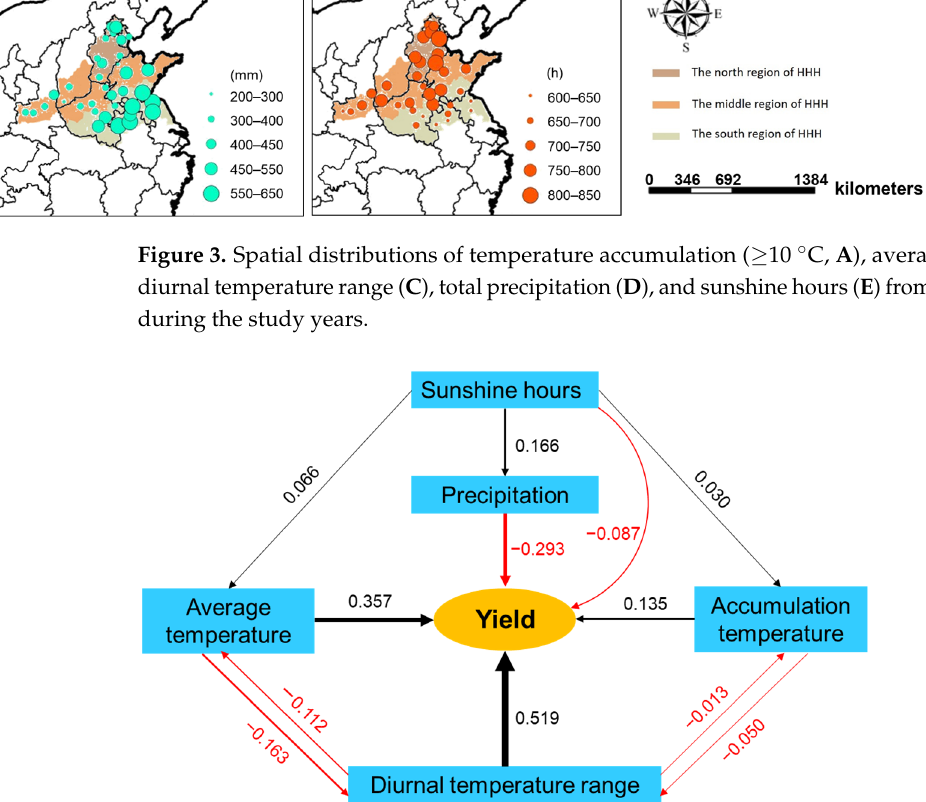
Figure 4. Path analysis of the relationships among seed yield, sunshine hours, total precipitation, average temperature, temperature accumulation (≥10 °C), and diurnal temperature range. Arrows point from causes and effects. Black arrows represent positive effects, and red arrows represent negative effects. The values along the arrows are path coefficients.